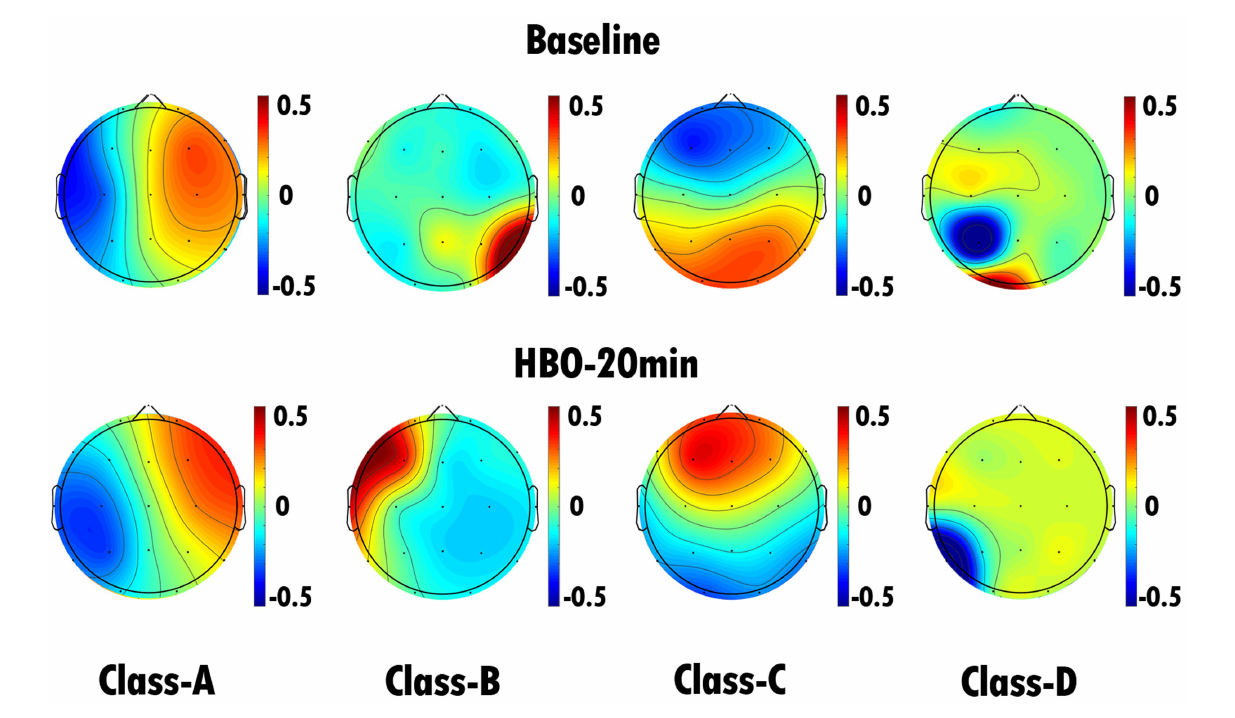
FIGURE 1 EEG microstate topography of all DOC patients (41 cases). The top row is the EEG microstate topography map of 41 DOC patients before HBO therapy, and the bottom row is the EEG microstate topography map of 41 DOC patients after 20 min of HBO therapy. Through statistical analysis, we found that the duration of microstate C in patients significantly increased after 20 min of HBO therapy compared with pretreatment ( p < 0.05).